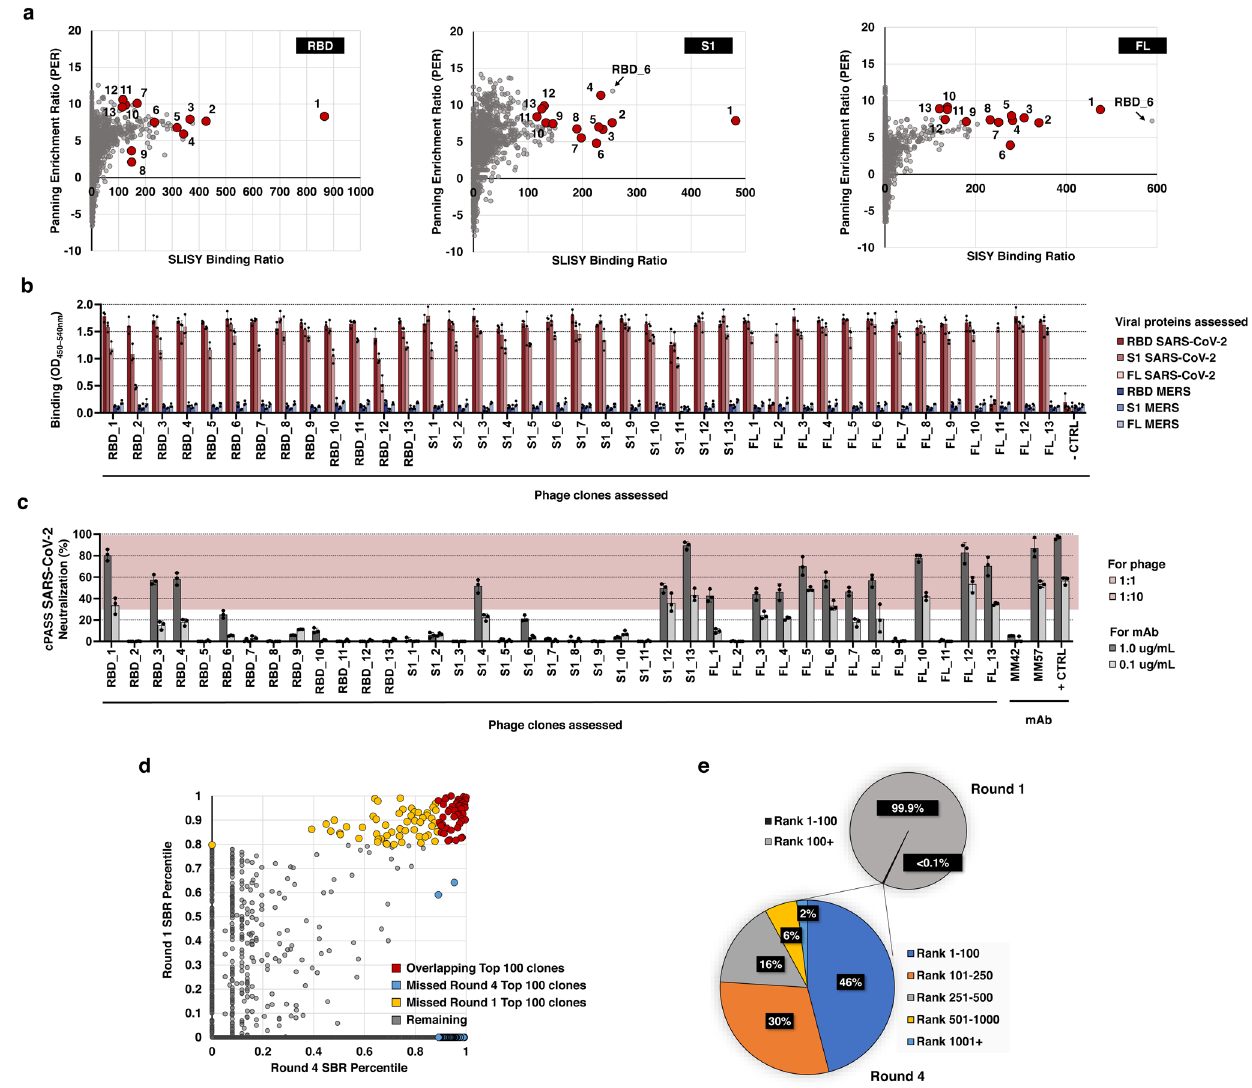
Fig. 3 | Validation of highly speci fi c SARS-CoV-2 clones. a SBRs for each clone is plotted against its PER from baseline after four rounds of biopanning. Red clones representthoseselectedforvalidation.Noteoneclone,RBD_6,washighlyenriched in all three biopanning strategies but only selected as an RBD candidate as indi- cated. b Binding speci fi city of candidate SARS-CoV-2 scFvs. Wells pre-coated